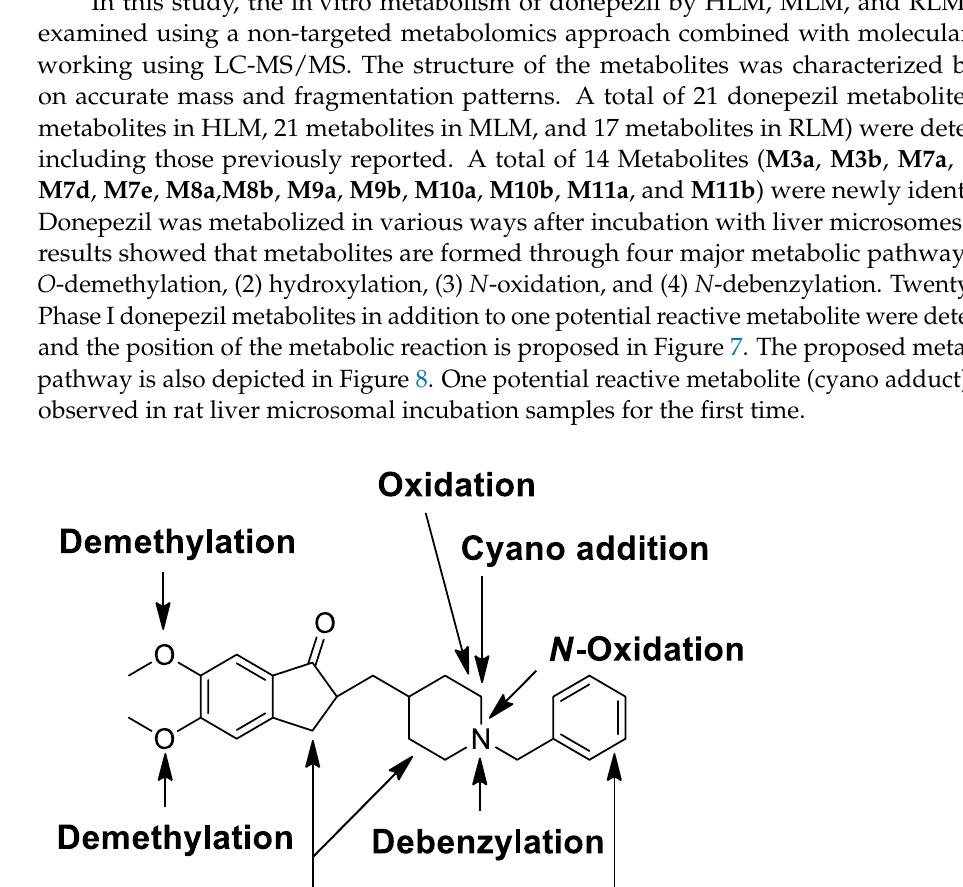
Figure 8. Proposed metabolic pathways of donepezil in human liver microsomes (H), rat liver microsomes (R), and mice liver microsomes (M).As a result of comparing metabolites between species, donepezil had similar metabolic profiles in HLM, MLM, and RLM. N- Desbenzydonepezil ( M5 ) was the most abundant metabolite in all incubations. Meier-Davis et al. (2012) also reported N- desbenzydonepezil as the most abundant metabolite in rat and human plasma following oral administration [37] and in rat plasma, liver, and kidney after a single oral administration of donepezil [25]. The metabolite